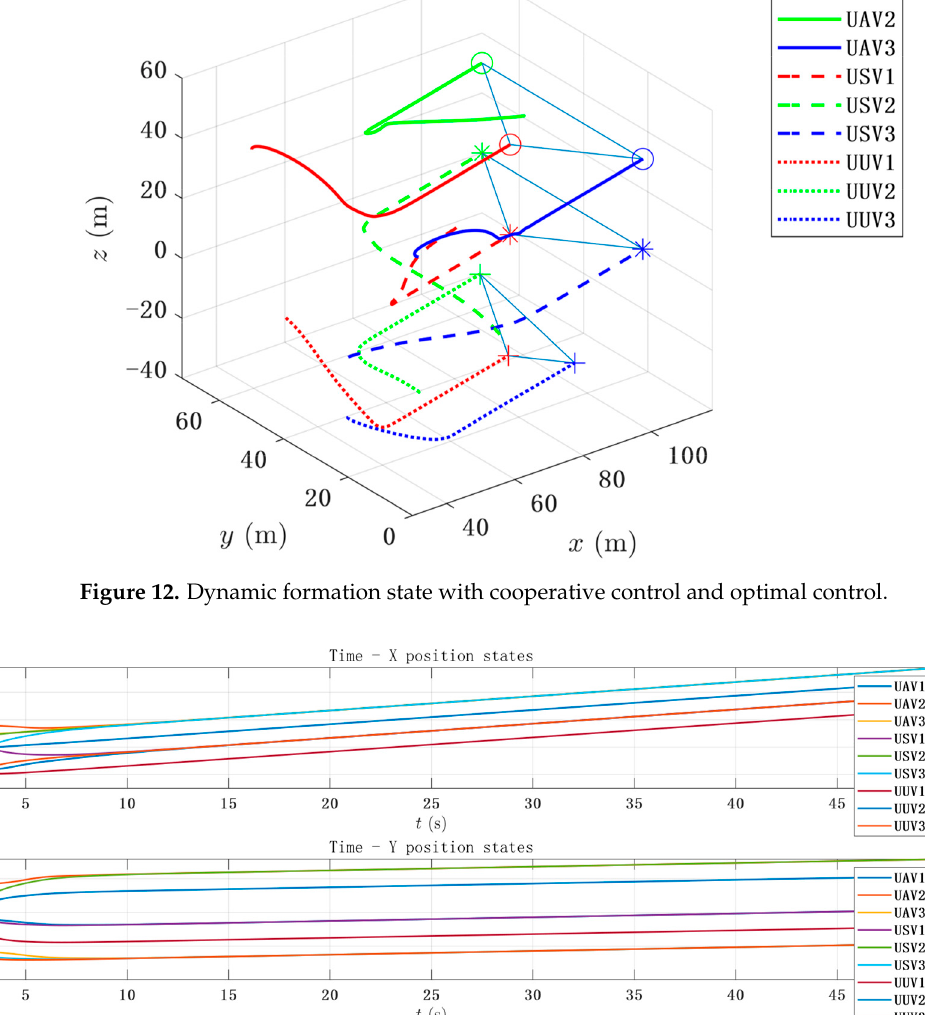
Figure 13. Position state with dynamic cooperative optimum formation control.